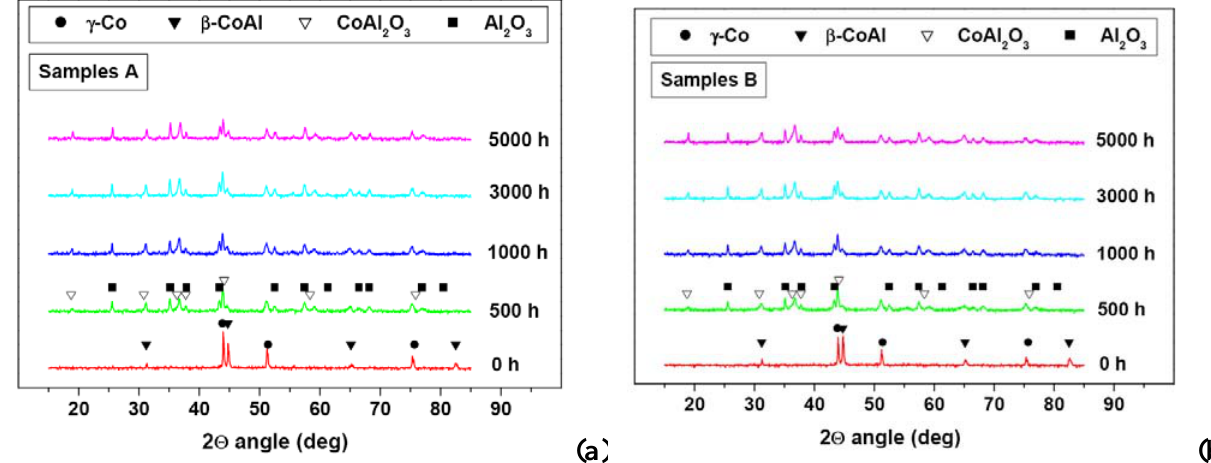
Figure 10. (a) XRD patterns of the surface of samples A before and after different periods of oxidation at 1,273 K. (b) XRD patterns of the surface of samples B before and after different periods of oxidation at 1,273